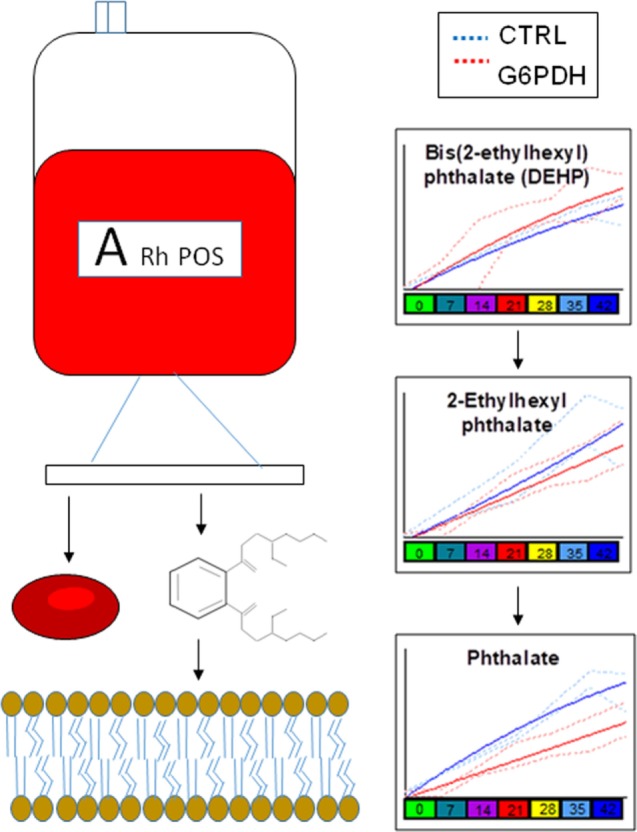
Different levels of phthalate plasticizers and breakdown products are observed in red blood cells from glucose 6-phosphate dehydrogenase (G6PD) sufficient (blue line) and deficient (red line) during storage in the blood bank (median + ranges are shown in light blue or red for both G6PD sufficient and deficient groups, respectively).